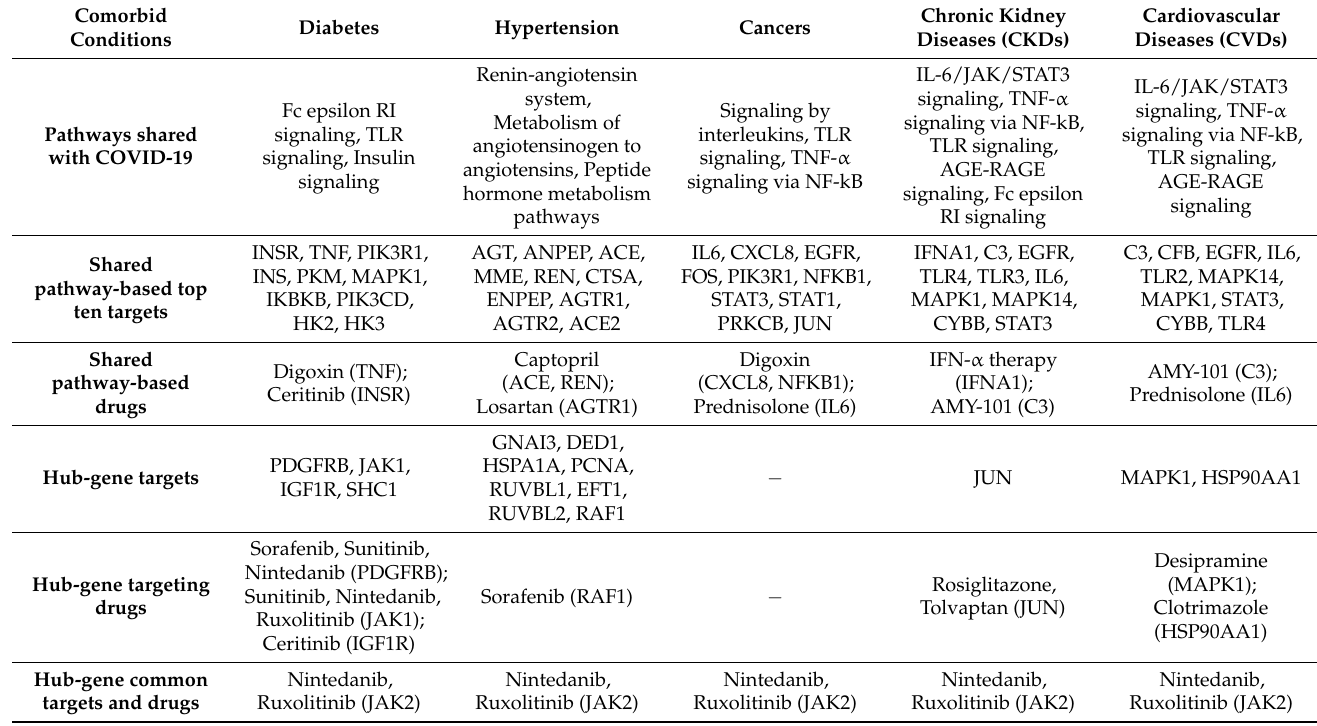
Table 1. Summary of the identified pathway crosstalk between COVID-19 and associated five comorbidities. Comorbid